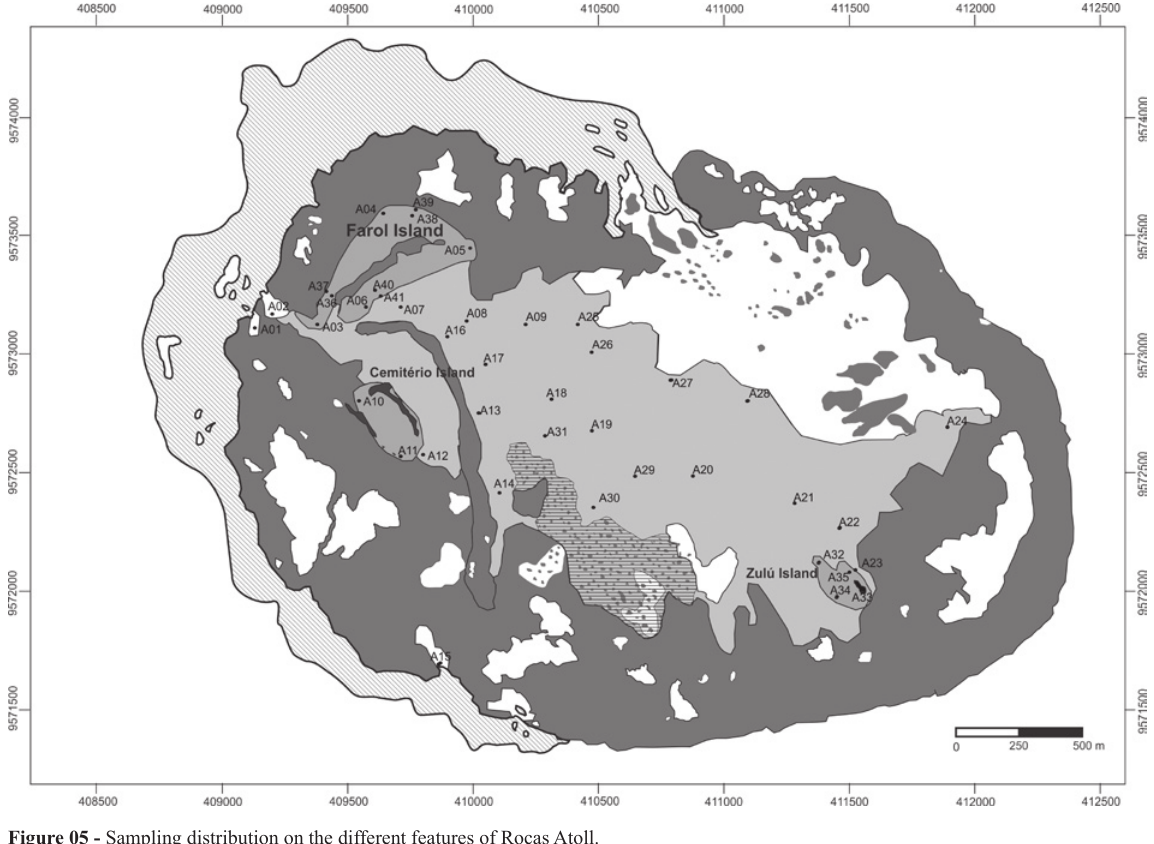
Figure 05 - Sampling distribution on the different features of Rocas Atoll.